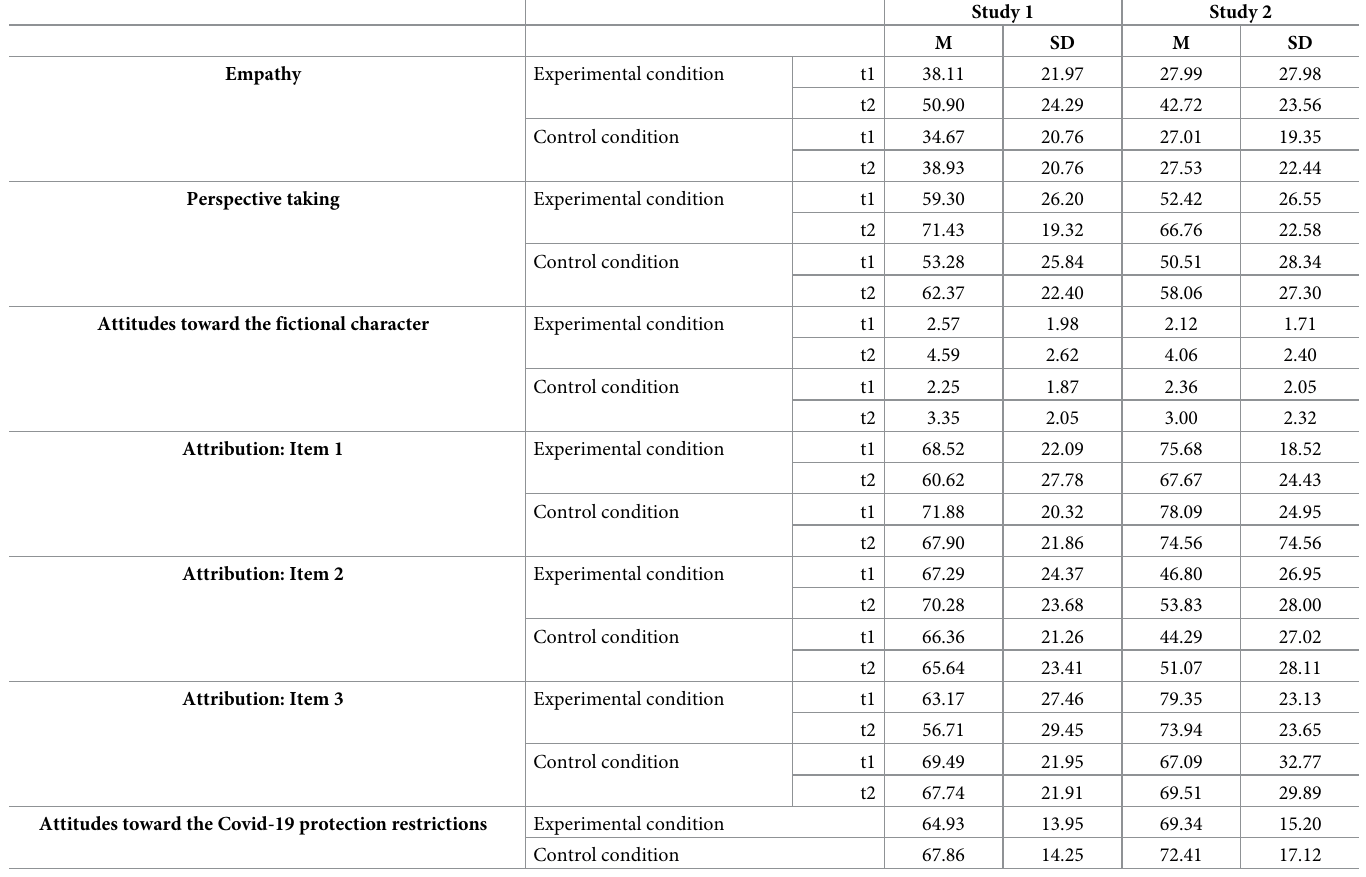
Table 4. Means and standard deviations of the outcome variables in the experimental and the control